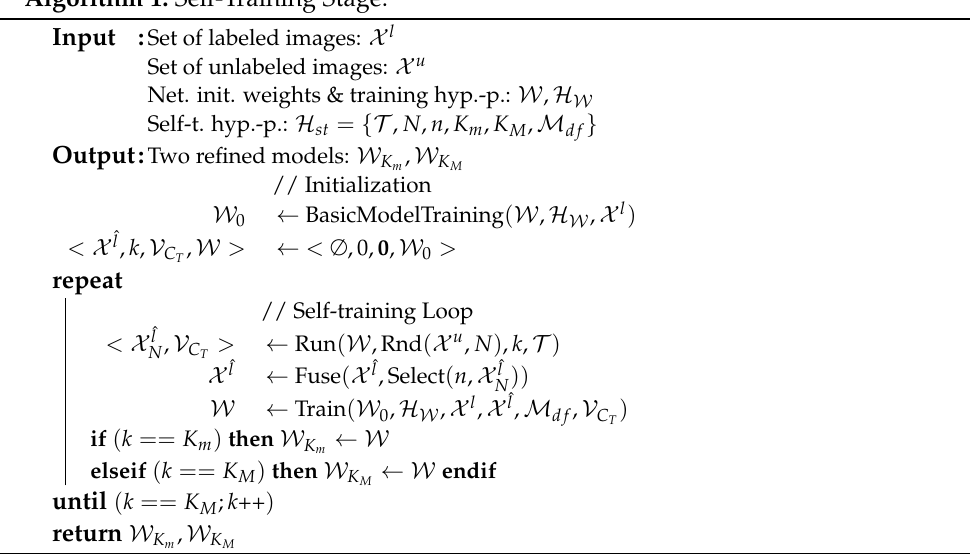
Algorithm 1: Self-Training